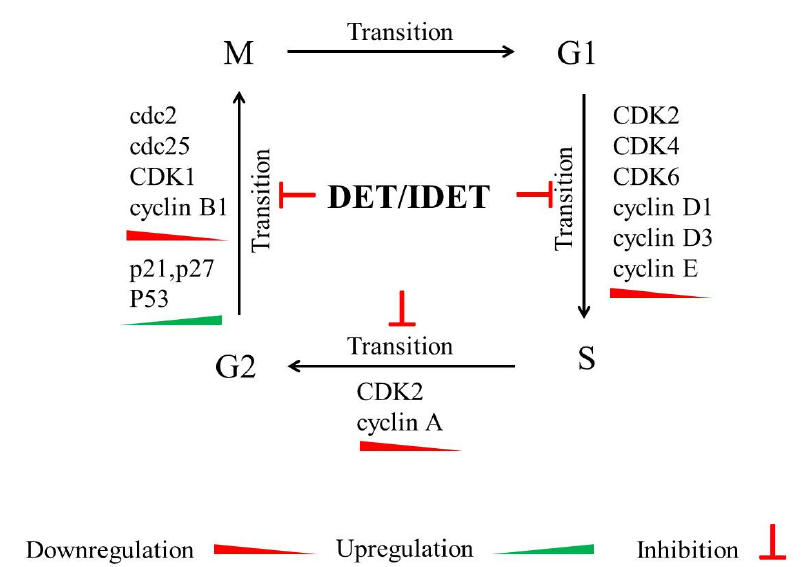
Figure 2. A schematic model of DET- and IDET-induced cell cycle arrest at multiple phases. DET and IDET inhibit S phase transition by downregulating the expression of cyclin A, cyclin D1, cyclin D3, cyclin E, CDK2, CDK4, and CDK6. DET and IDET inhibit G2/M phase transition by downregulating the expression of cdc2, cdc25, cyclin B1, and CDK1 while upregulating the expression of p21 Waf1/Cip1 and p27 Cip/Kip (CDK inhibitors) and p53, a tumor suppresser gene which regulates cell cycle arrest at different phases by inducing